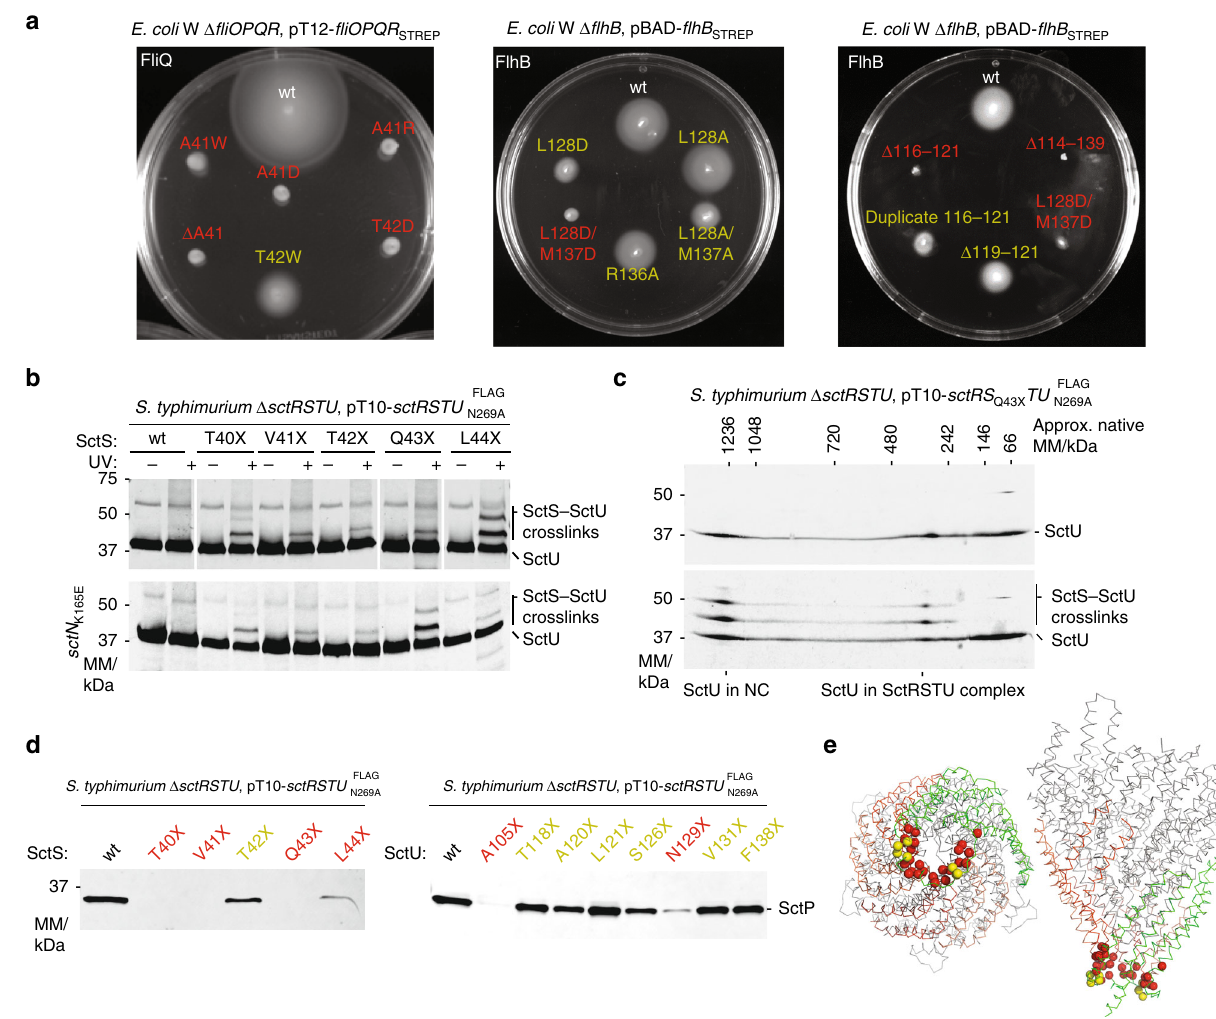
Fig. 4 Functional analysis of FlhB L . a Motility in soft agar of E. coli W Δ fl iOPQR complemented with plasmids expressing fl iOPQR with the indicated mutations in FliQ (left) and E. coli W Δ fl hB complemented with plasmids expressing FlhB with the indicated mutations (middle and right). b Immunodetection of SctU FLAG on western blottings of SDS-PAGE-separated crude membrane samples of the indicated S . typhimurium SctS p Bpa mutants (denoted with X). Each sample is shown with and without UV-irradiation to induce photocrosslinking of p Bpa to neighbouring interaction partners. Crosslinks between SctS p Bpa and SctU FLAG are indicated. Crosslinking analysis was performed in the wild type and in an ATP hydrolysis-de fi cient SctN K165E mutant that is incapable of type III secretion. c Immunodetection of SctU FLAG on western blottings of 2D blue native/SDS-PAGE-separated crude membrane samples of the indicated S . typhimurium SctS p Bpa mutant. The sample is shown with and without UV-irradiation to induce photocrosslinking of p Bpa to neighbouring interaction partners. Crosslinks between SctS p FLAG in the SctRSTU assembly intermediate and in the assembled needle Bpa and SctU complex (NC) are indicated. d Immunodetection of the early T3SS substrate SctP on western blottings of SDS-PAGE-separated culture supernatants of the indicated S . typhimurium SctS p Bpa mutants. e Structure of FliPQR – FlhB highlighting mutation sites that impaired motility or secretion in red and mutation sites that had no or only a small effect in